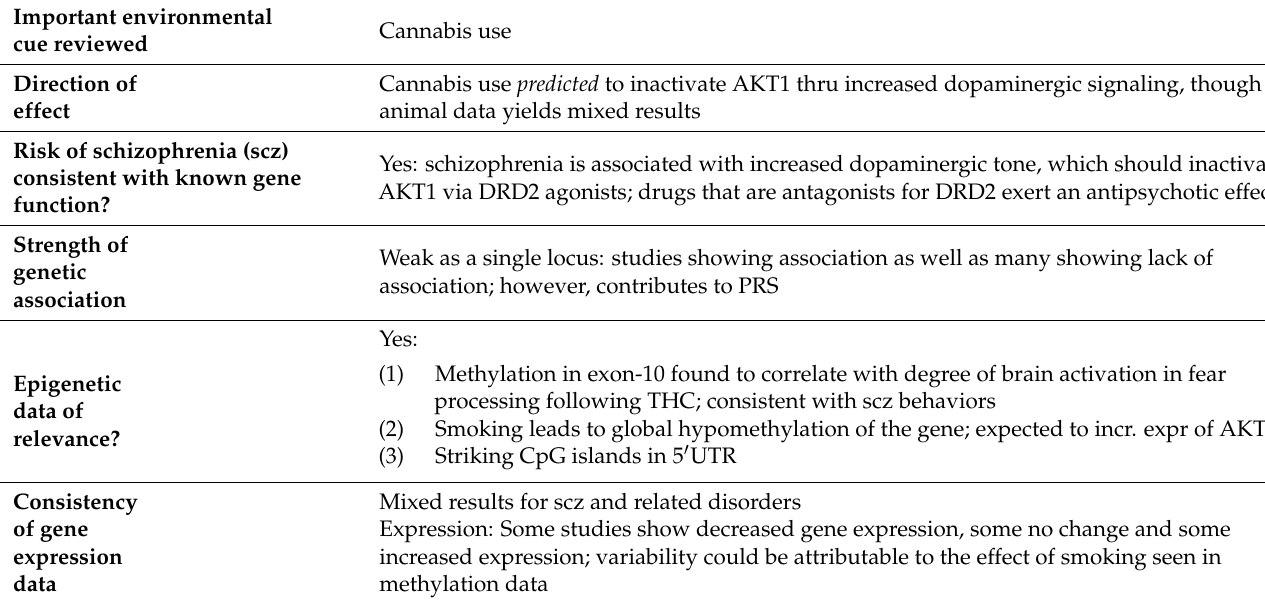
Table 2. Summary of major points for the gene